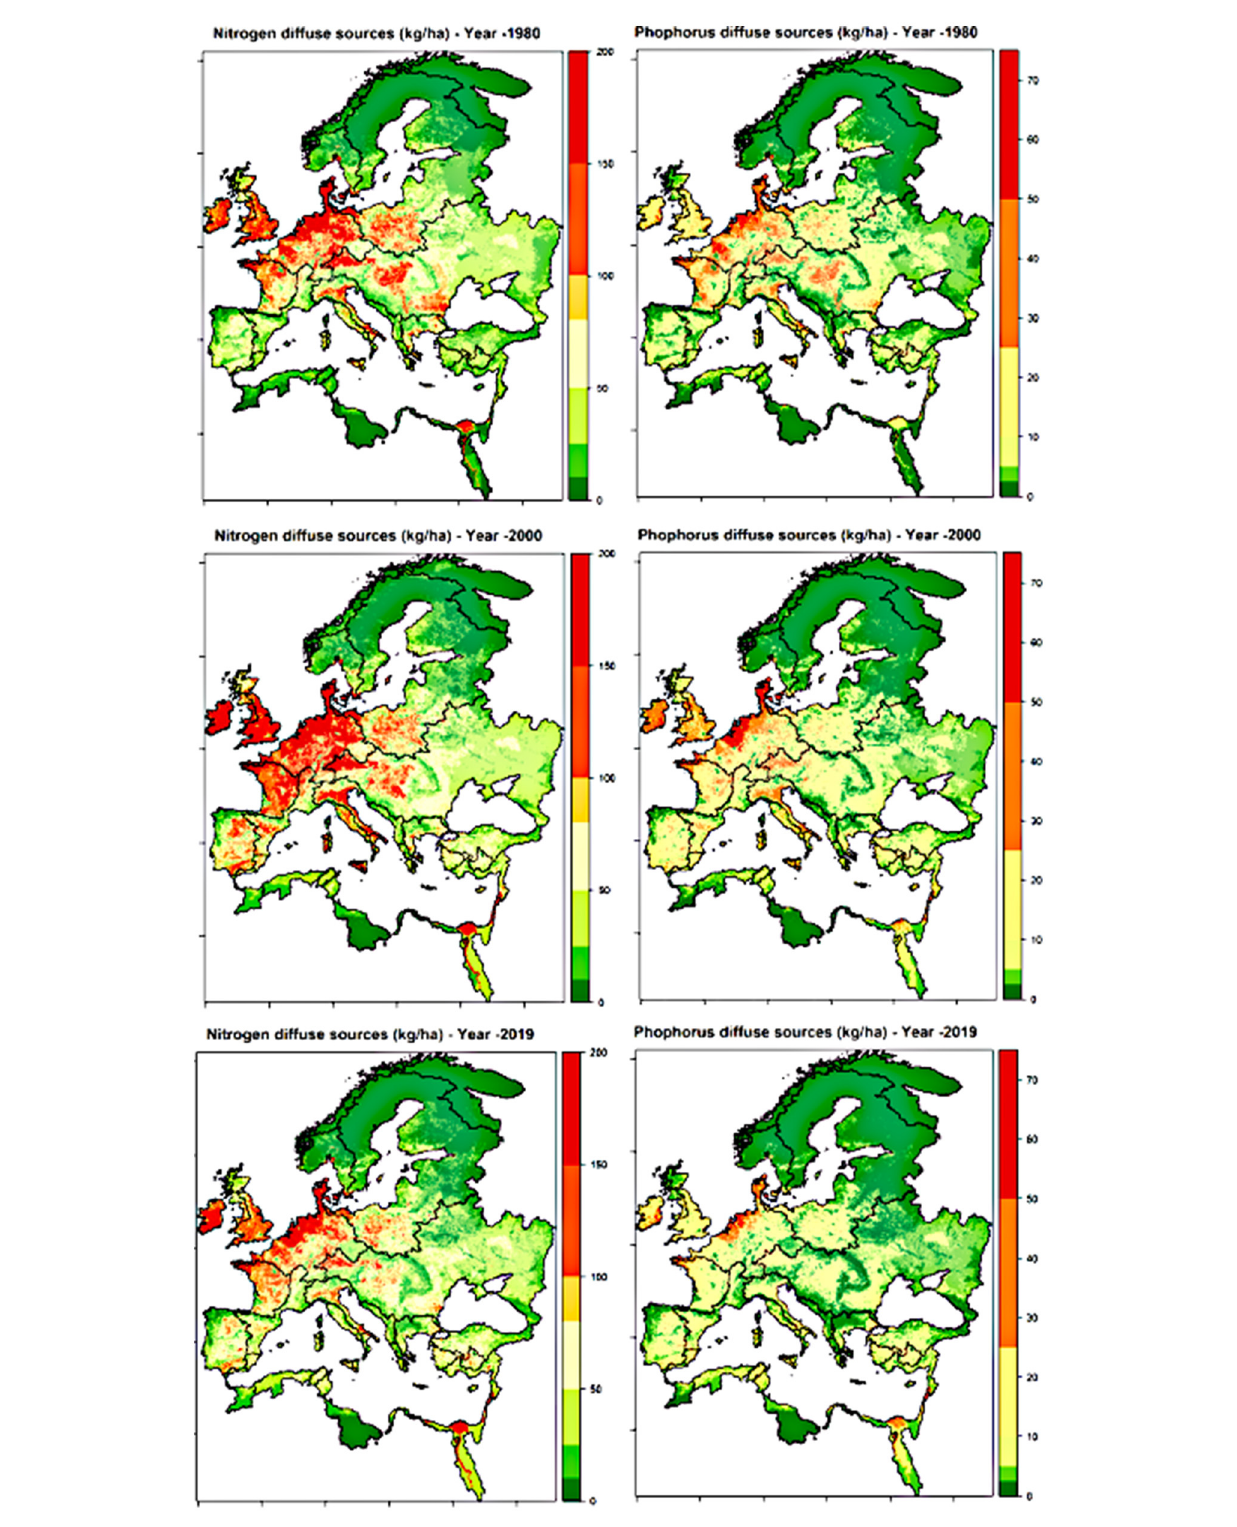
FIGURE2 Spatial variation of N and P diffuse sources for the years 1980, 2000, and 2019 (Point sources maps in the SI).